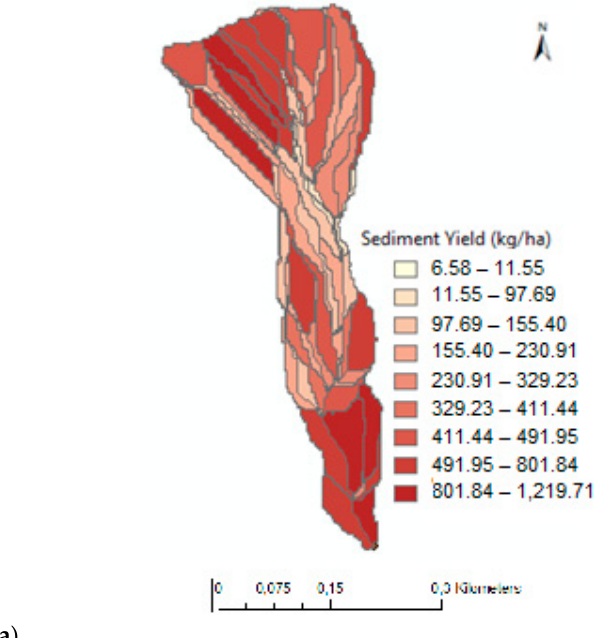
Table 5. Sedimentological results for each method (including Event 7) [3].